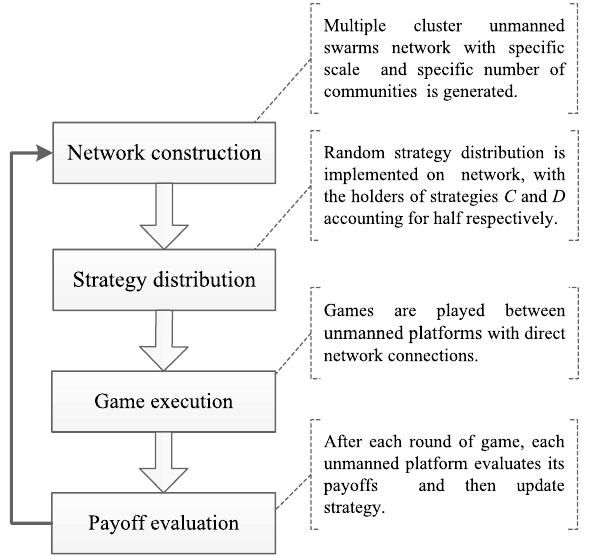
Figure 5. The dynamic processes of collaborative evolution in unmanned swarms.